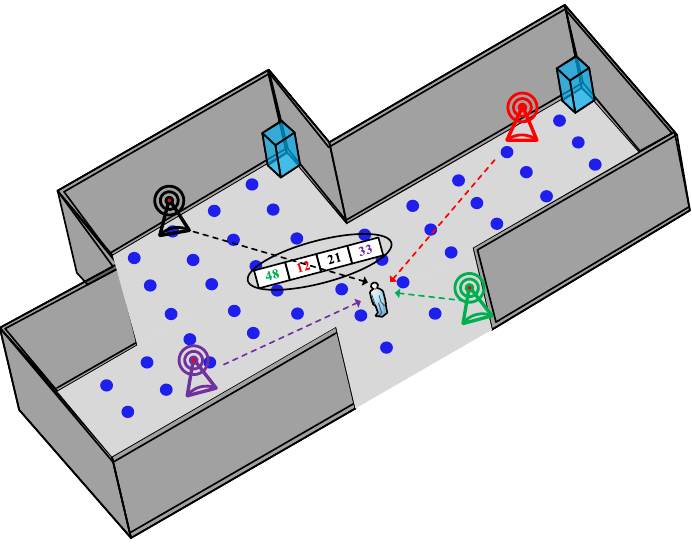
Figure 1. The fundamentals of WiFi fingerprinting indoor localization .